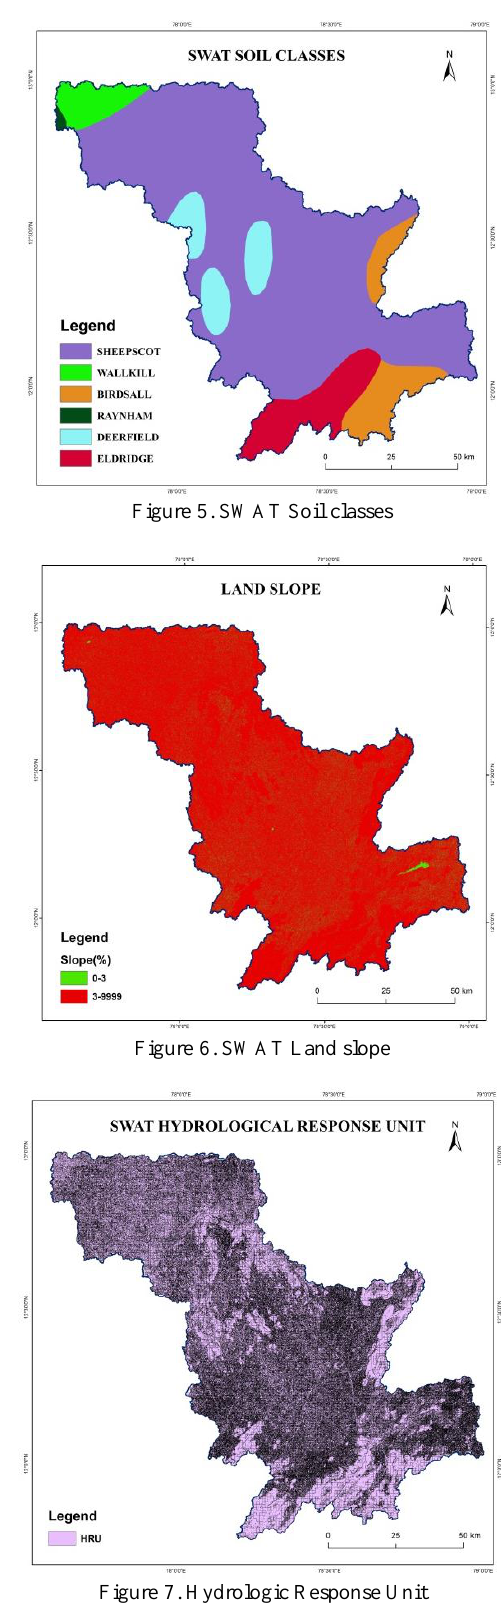
Figure 7. Hydrologic Response